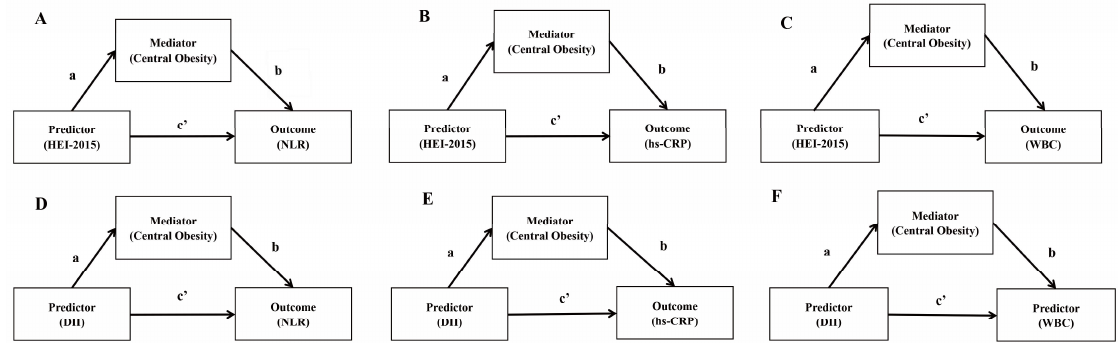
Figure 3. Mediation model path diagram. ( a ) The effect of dietary scores on central obesity; ( b ) the effect of central obesity on inflammatory markers; ( c ) direct effect of predictors on inflammatory markers. ( A – F ) show different potential paths, respectively.